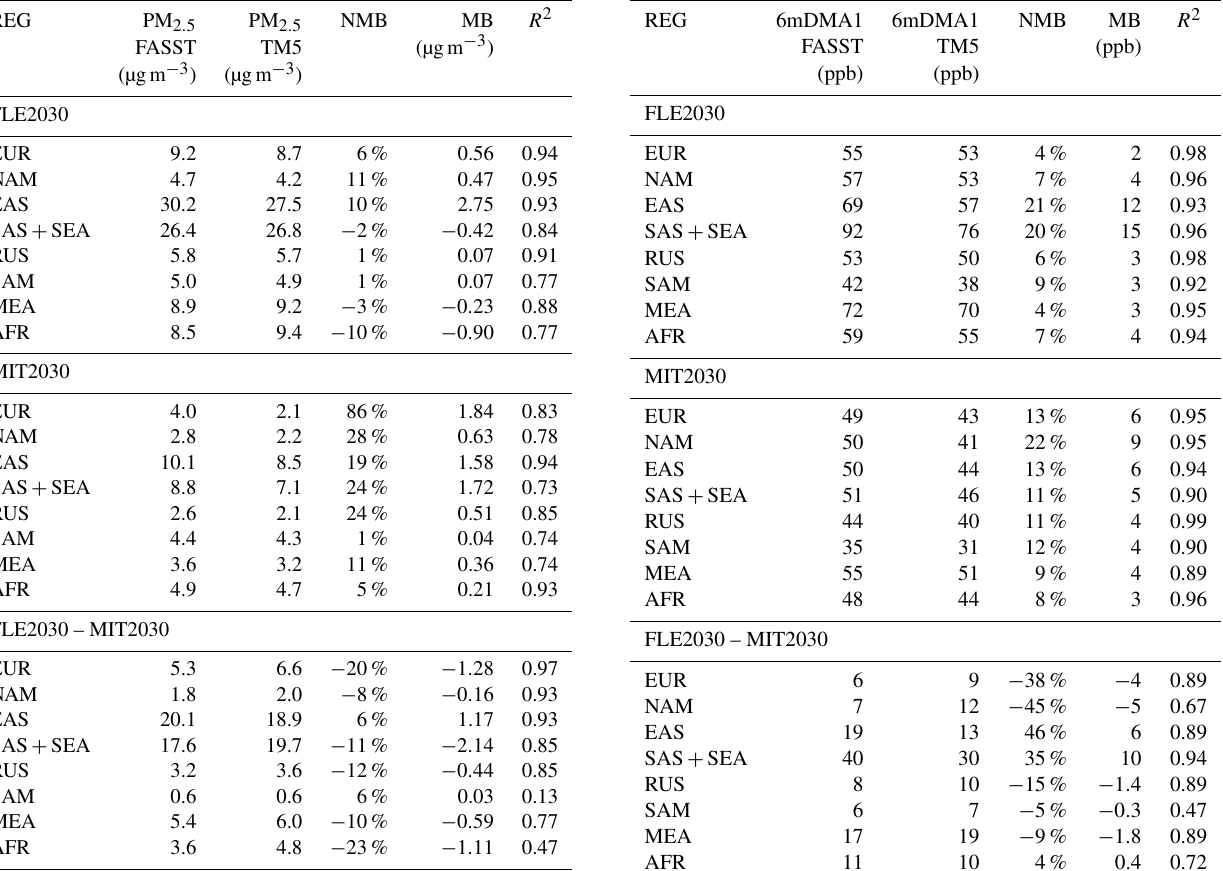
Table 8. Regional grid cell mean anthropogenic PM 2 . 5 con- centration (including primary and secondary components) and performance statistics for FASST versus TM5, for the high- emission (FLE2030) and low-emission (MIT2030) scenarios and for the delta. See Table S2.2 for the region legend.